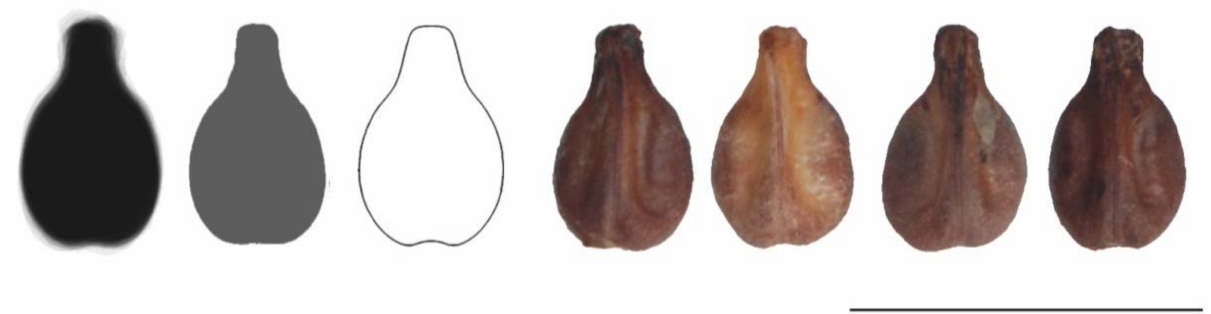
Figure 12. Moscatel model. From left to right: A sum of the silhouettes of 30 seeds of the cultivar Mollar Cano, average silhouette for this cultivar obtained by the pixel profile of the first image, the Moscatel model, and four representative seeds of cultivar Mollar Cano. Bar represents 1